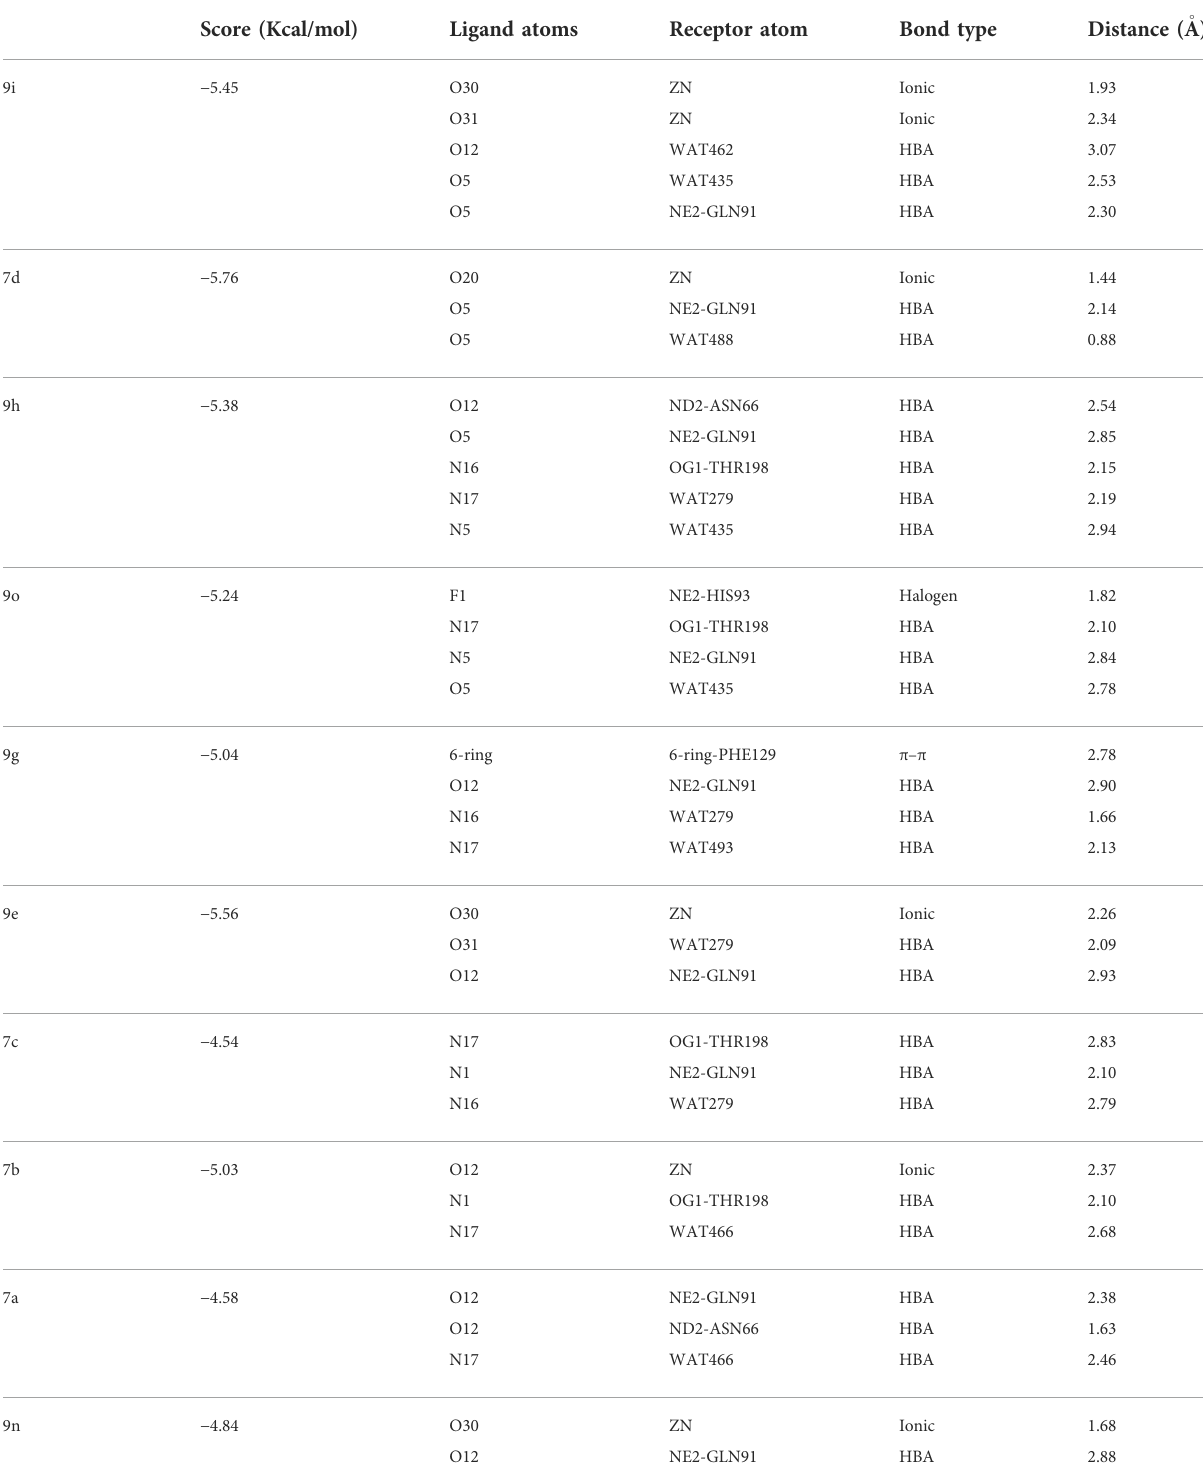
TABLE 4 Binding analysis of active 1H-1,2,3-triazole analogues in the active site of bCA-II.